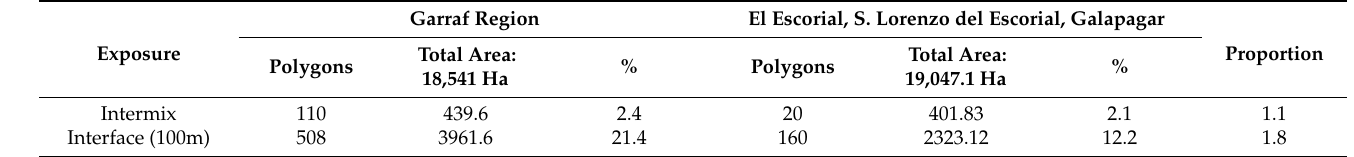
Table 2. Proportion of study areas